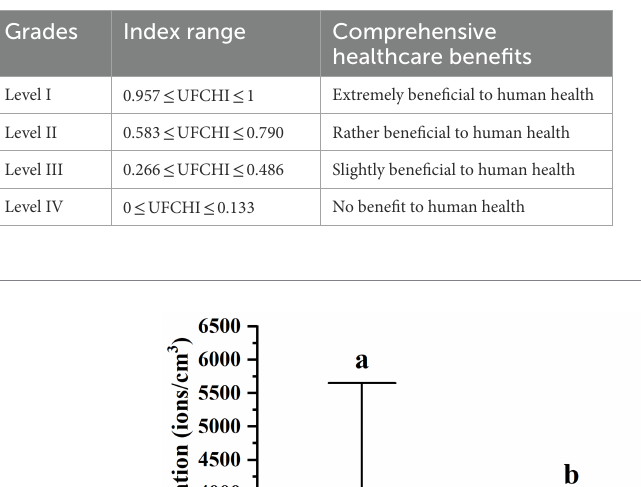
TABLE 5 The evaluation criteria for